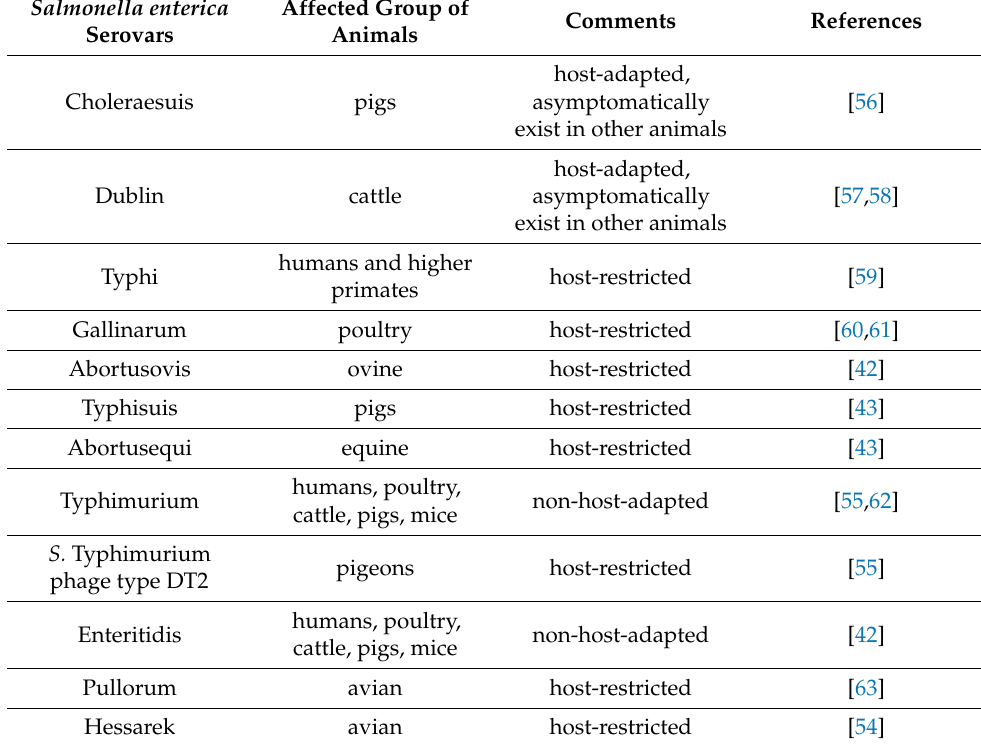
Table 2. Host specificity of Salmonella